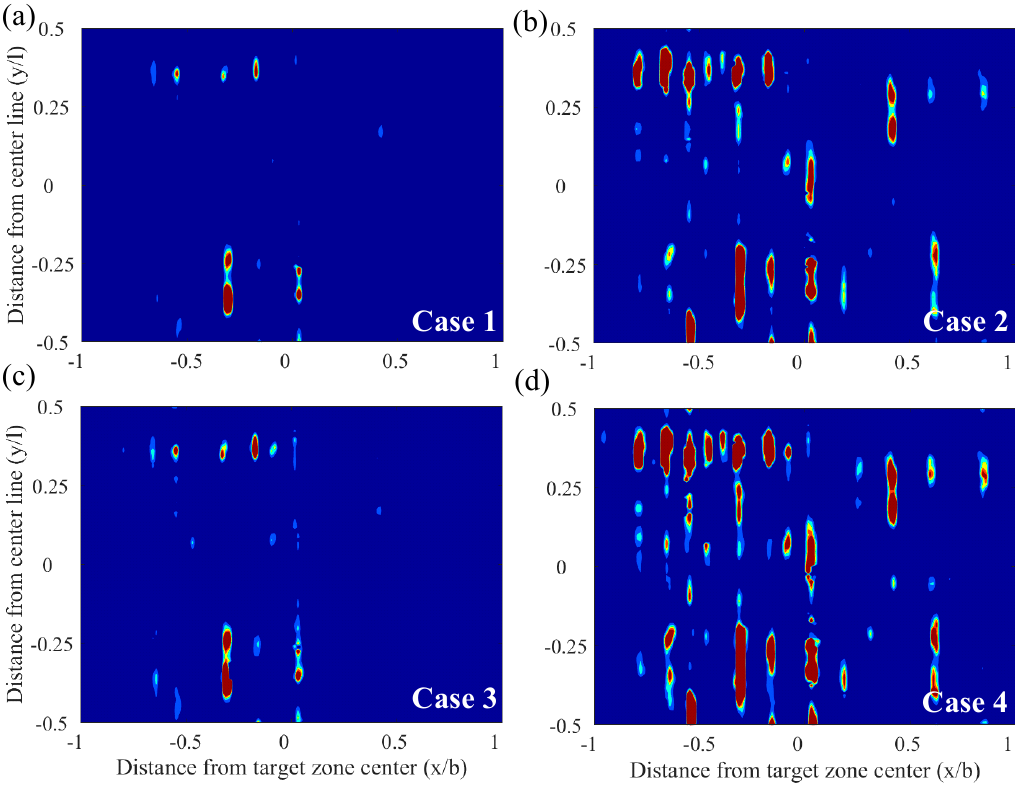
Figure 13. Damage risk of Cases 1–4 after 10 million cycles.